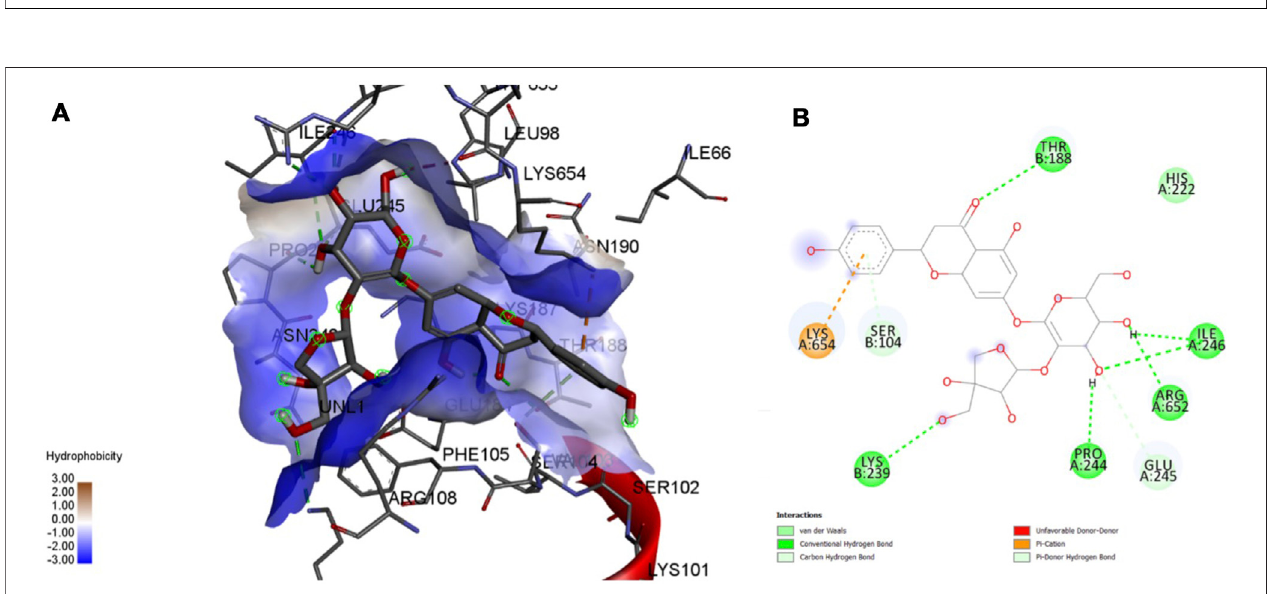
FIGURE 10 | Molecular docking interaction analysis of protein 5A63, (A) : 3D interactions and (B) : 2D interactions have been represented between 5A63-Apiin complex structures.